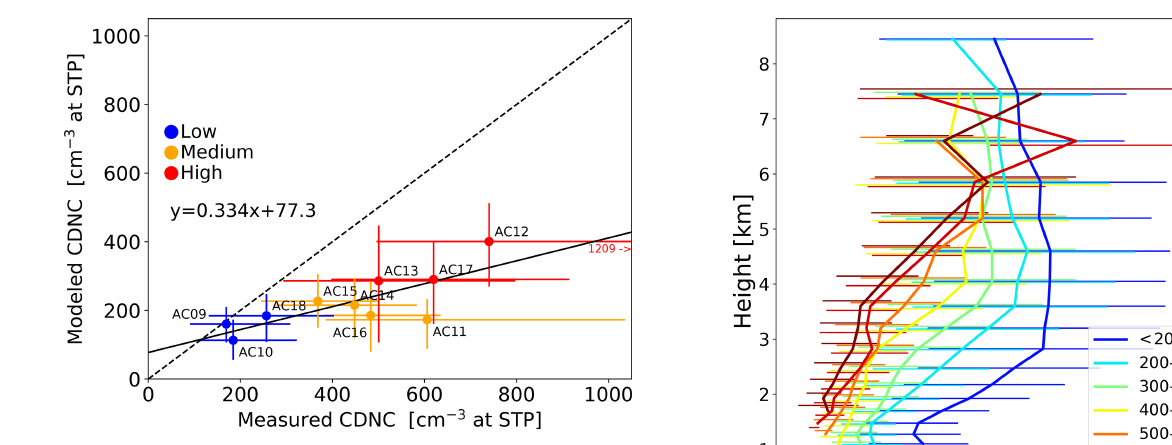
Figure 2. Median cloud droplet number concentration from the WRF domain and in situ measurements. The colors correspond to the CCN-level labels in Table 1. Error bars depict the interquartile range (25%–75% of all values). The equation describes the (solid black) regression line. The dashed black line is a 1-to-1 line for ref- erence. STP refers to standard temperature (273.15K) and pressure (1000hPa).